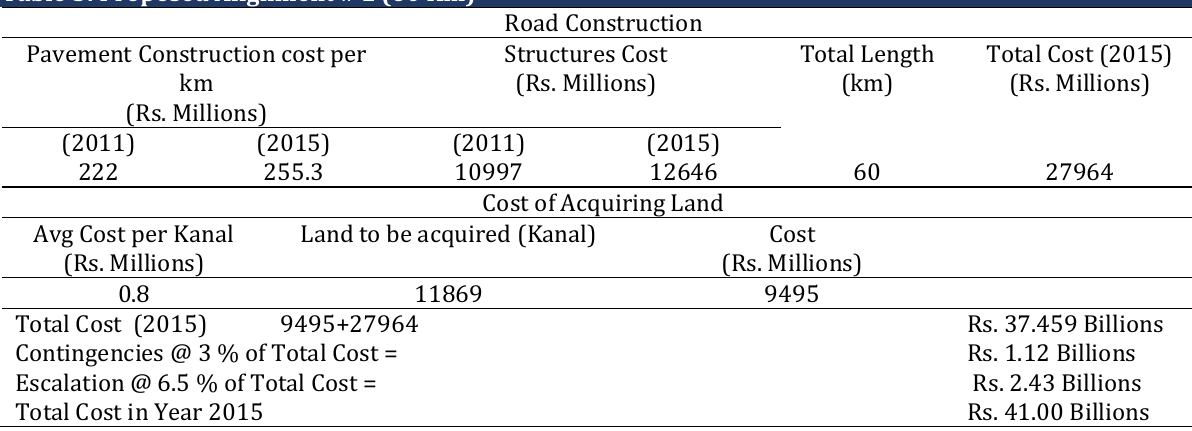
Table 3: Proposed Alignment # 1 (60 Km)